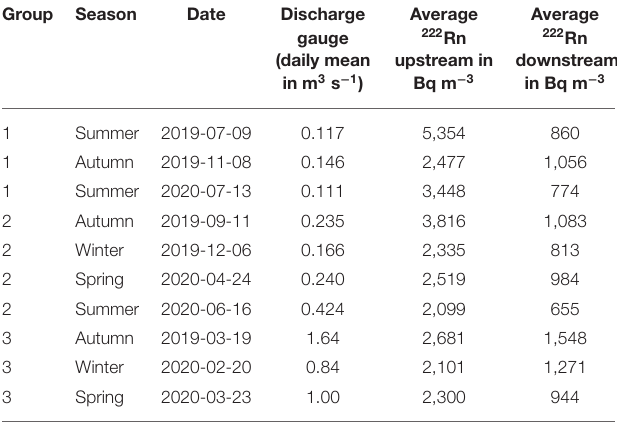
TABLE 2 | Summary of the campaigns divided into three